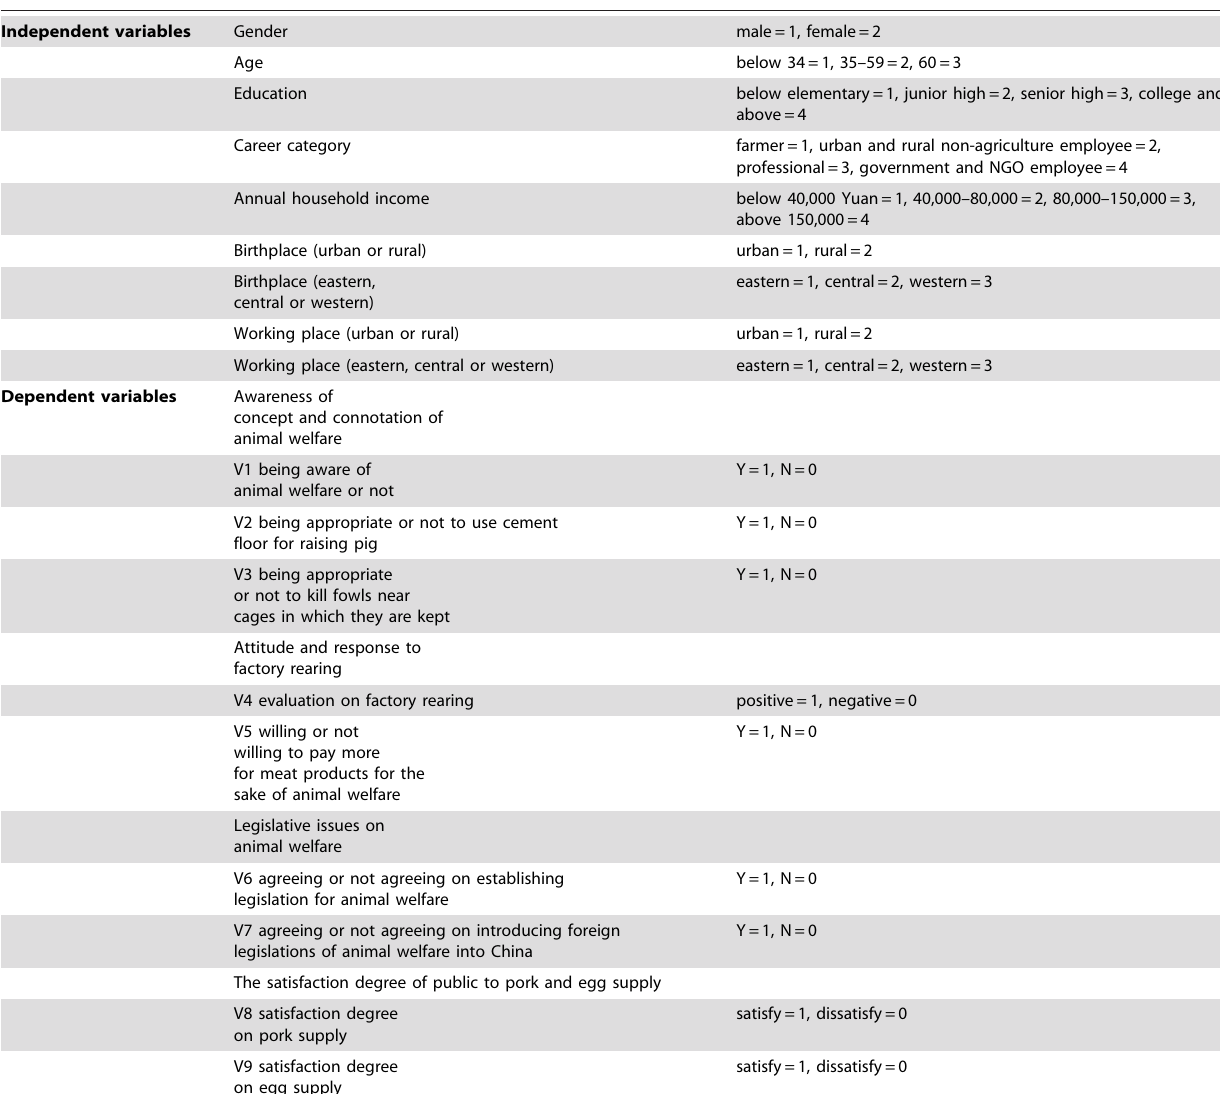
Table 1. Variables and Assignment.